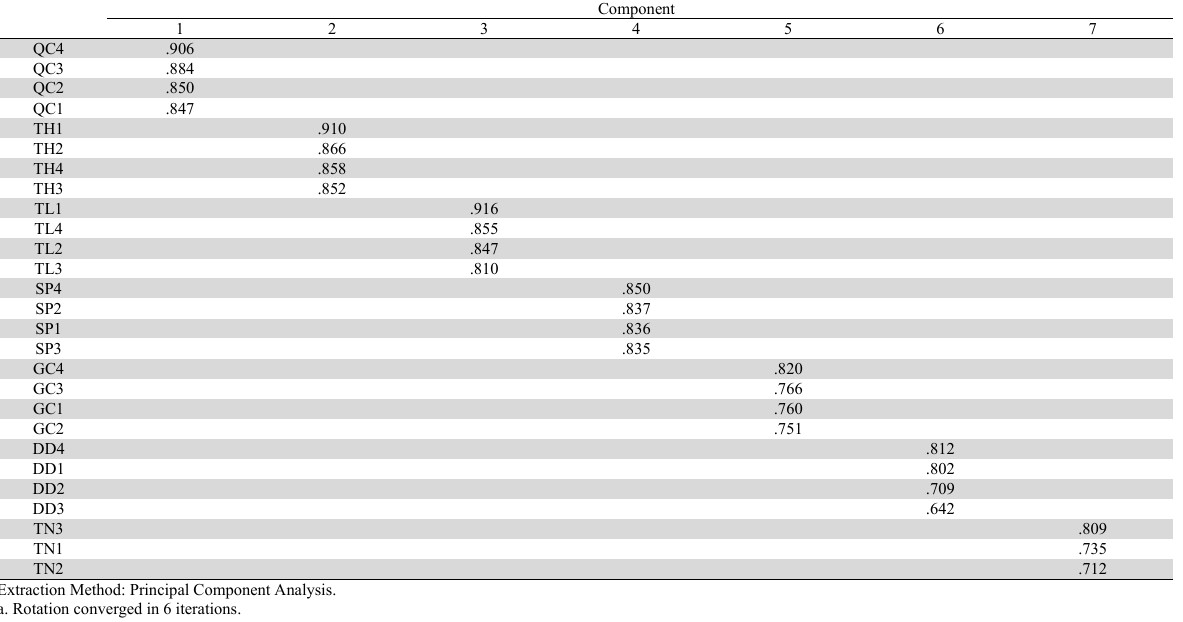
Rotated Component Matrix